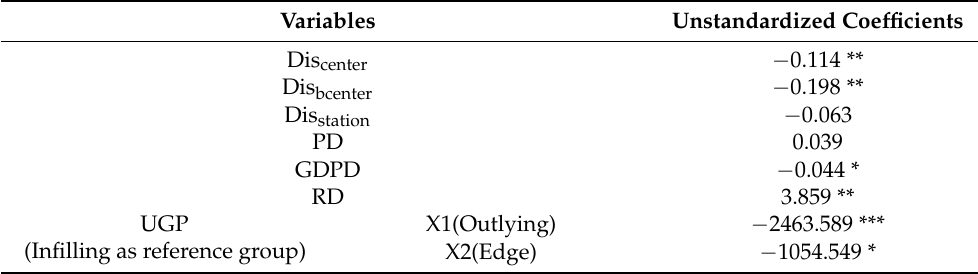
Table 3. Regression relationship between urban vitality and driving